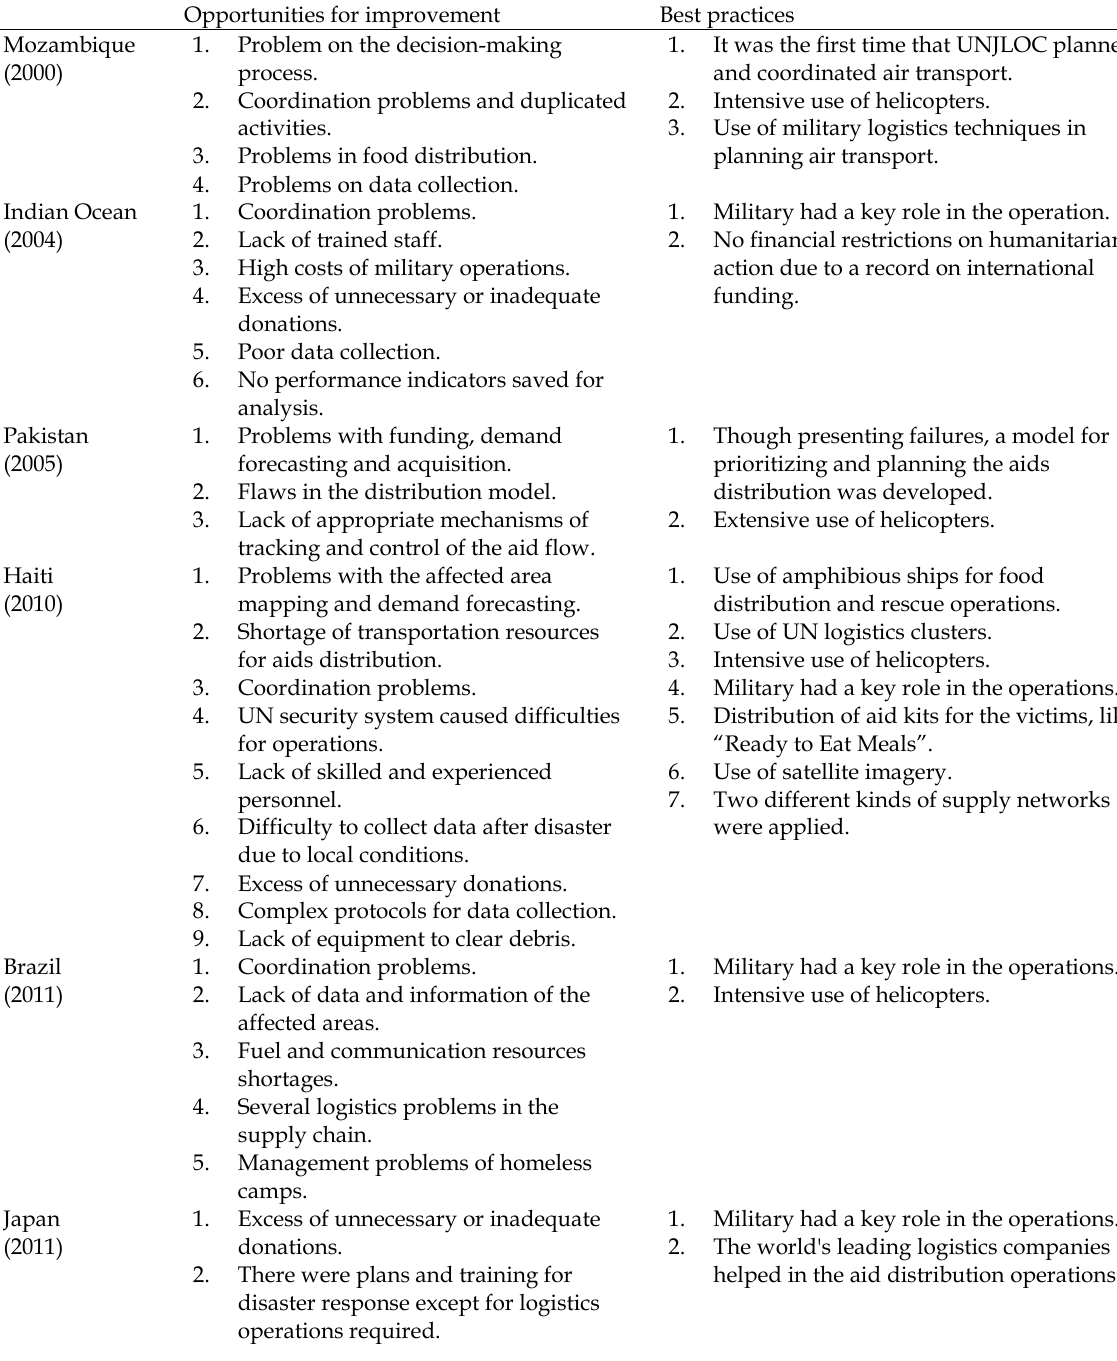
Table 2. Research topics in the field of humanitarian